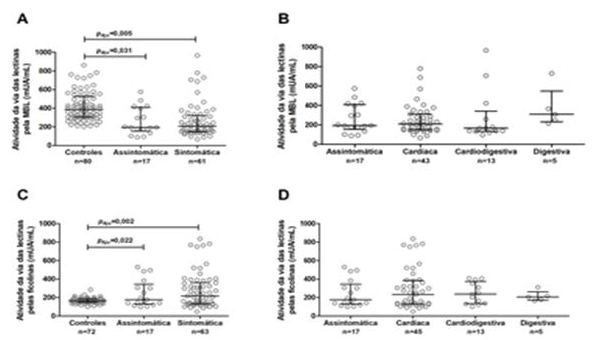
fIGuRE 3 – Functional assessment of lectin pathway activity in controls and in the different clinical forms of chronic